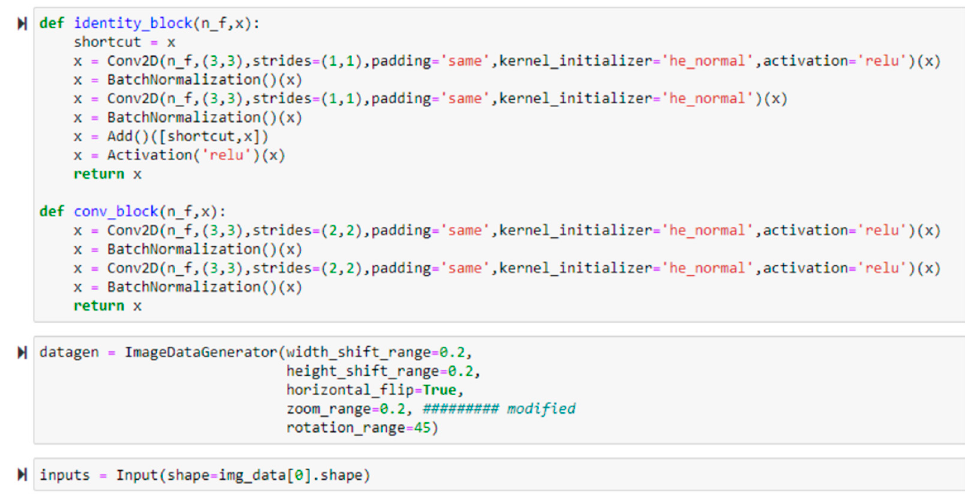
Figure 5. Building the residual block of the ResNet-like model.